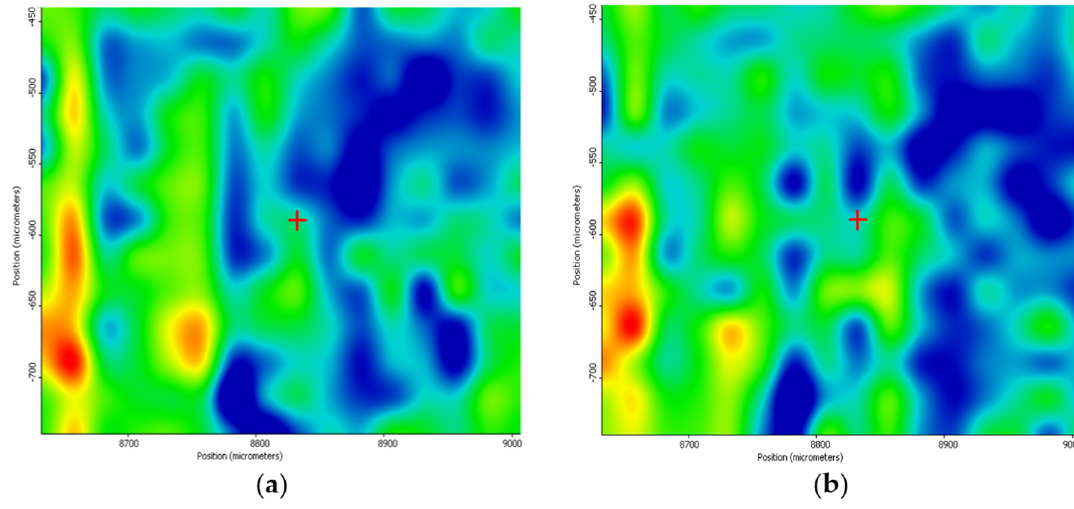
Figure 10 Figure 10. IR maps of PVP/ZnO@LiN dropcast based on the distribution of C–H ( a ) and C=O ( b )